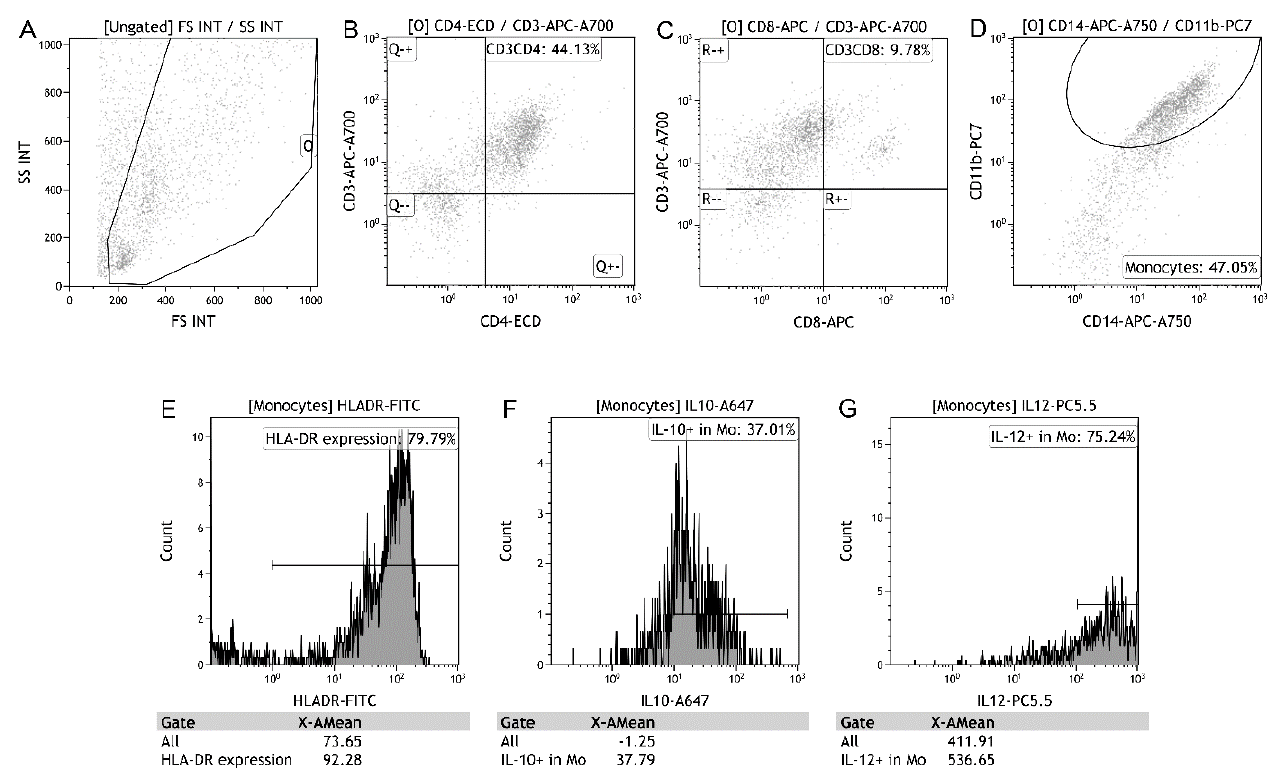
Figure 1. Flow cytometry of bronchoalveolar lavage (BAL) cells on day 1. Cells in area O were gated as BAL mononuclear cells in the scatterplot of forward scatter (FS) and side scatter (SS) ( A ). CD4 T lymphocytes were identified through positive CD3 and CD4 ( B ). CD8 T lymphocytes were identified through positive CD3 and CD8 ( C ). Monocytes were identified through positive CD11b and CD14 ( D ). Expressions of human leukocyte antigen (HLA)-DR, interleukin (IL)-10, and IL-12 are represented in the histograms (( E – G ) respectively). In this patient, HLA-DR, IL-10, and IL-12 were expressed in 79.79, 37.01, and 75.24% of monocytes. The mean fluorescence intensities of HLA-DR, IL-10 and IL12 were 92.28, 37.79, and 536.65, respectively.